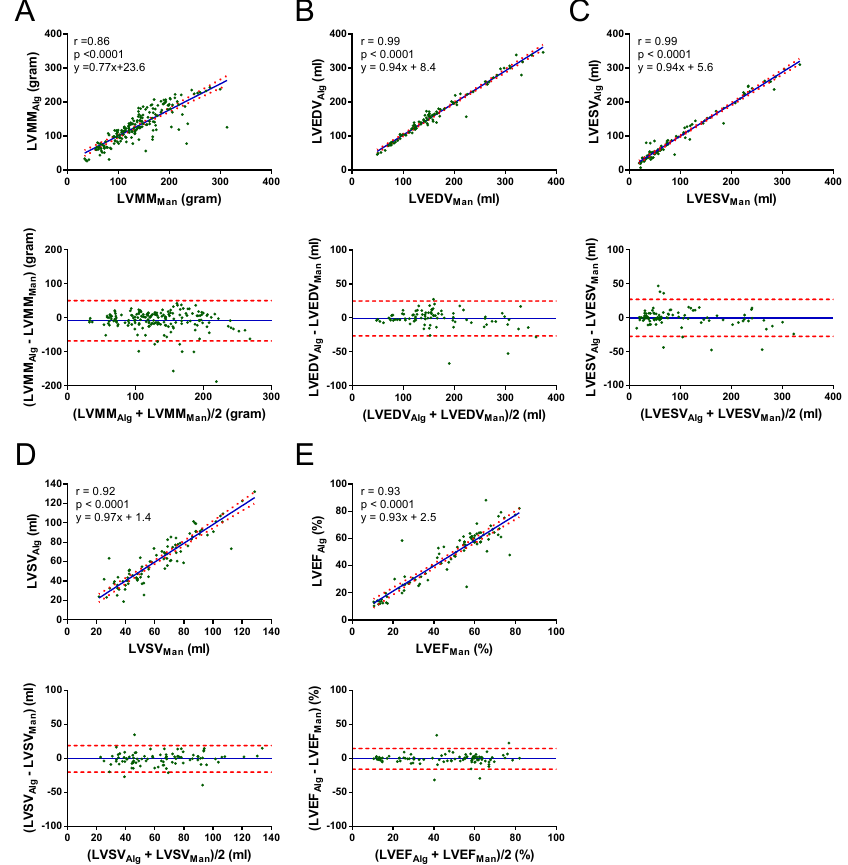
Figure 3. Relationships and agreement between the proposed algorithm vs. manual measurements of LVMM ( A ), LVEDV ( B ), LVESV ( C ), LVSV ( D ), and LVEF ( E ) ( n = 180 images from 90 subjects). Linear regression and Bland-Altman analyses of algorithm vs. manual LV indices are shown in the top and bottom plots, respectively. Alg : algorithm results; Man : manual results. Solid lines (blue) indicate the biases and dotted lines (red) represent the 95% limits of